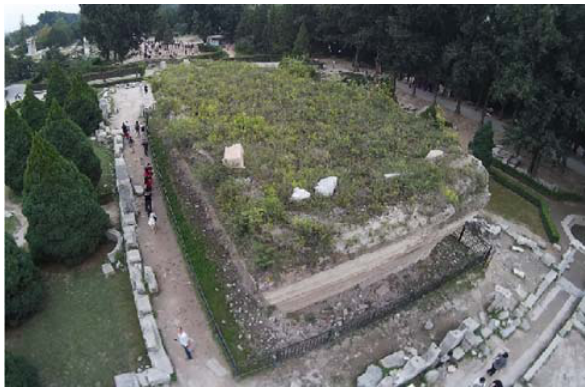
Figure 2. The present situation of the earthen relic